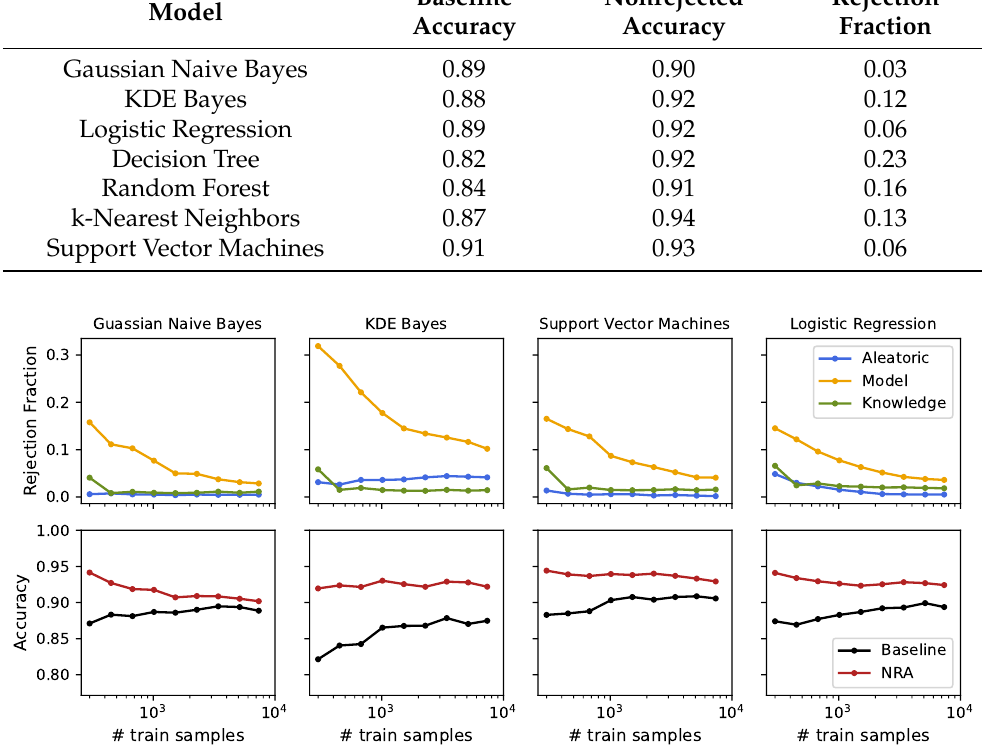
Figure 9. Uncertainties’ rejection fraction and obtained accuracies with the increasing number of training samples for the Human Activity Recognition (HAR)